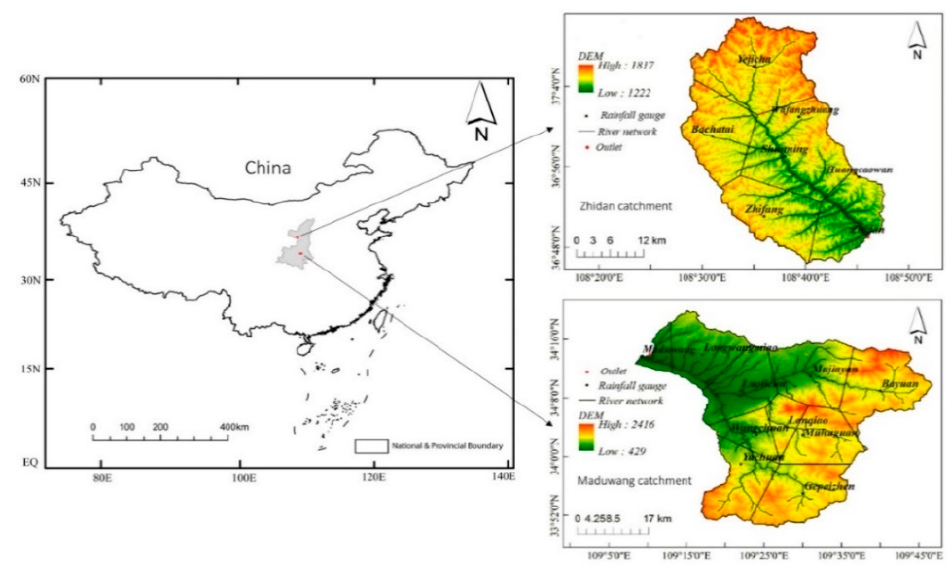
Figure 1. Zhidan and Maduwang catchment areas showing the river network with the meteorological stations and the hydrometeorological (outlet)